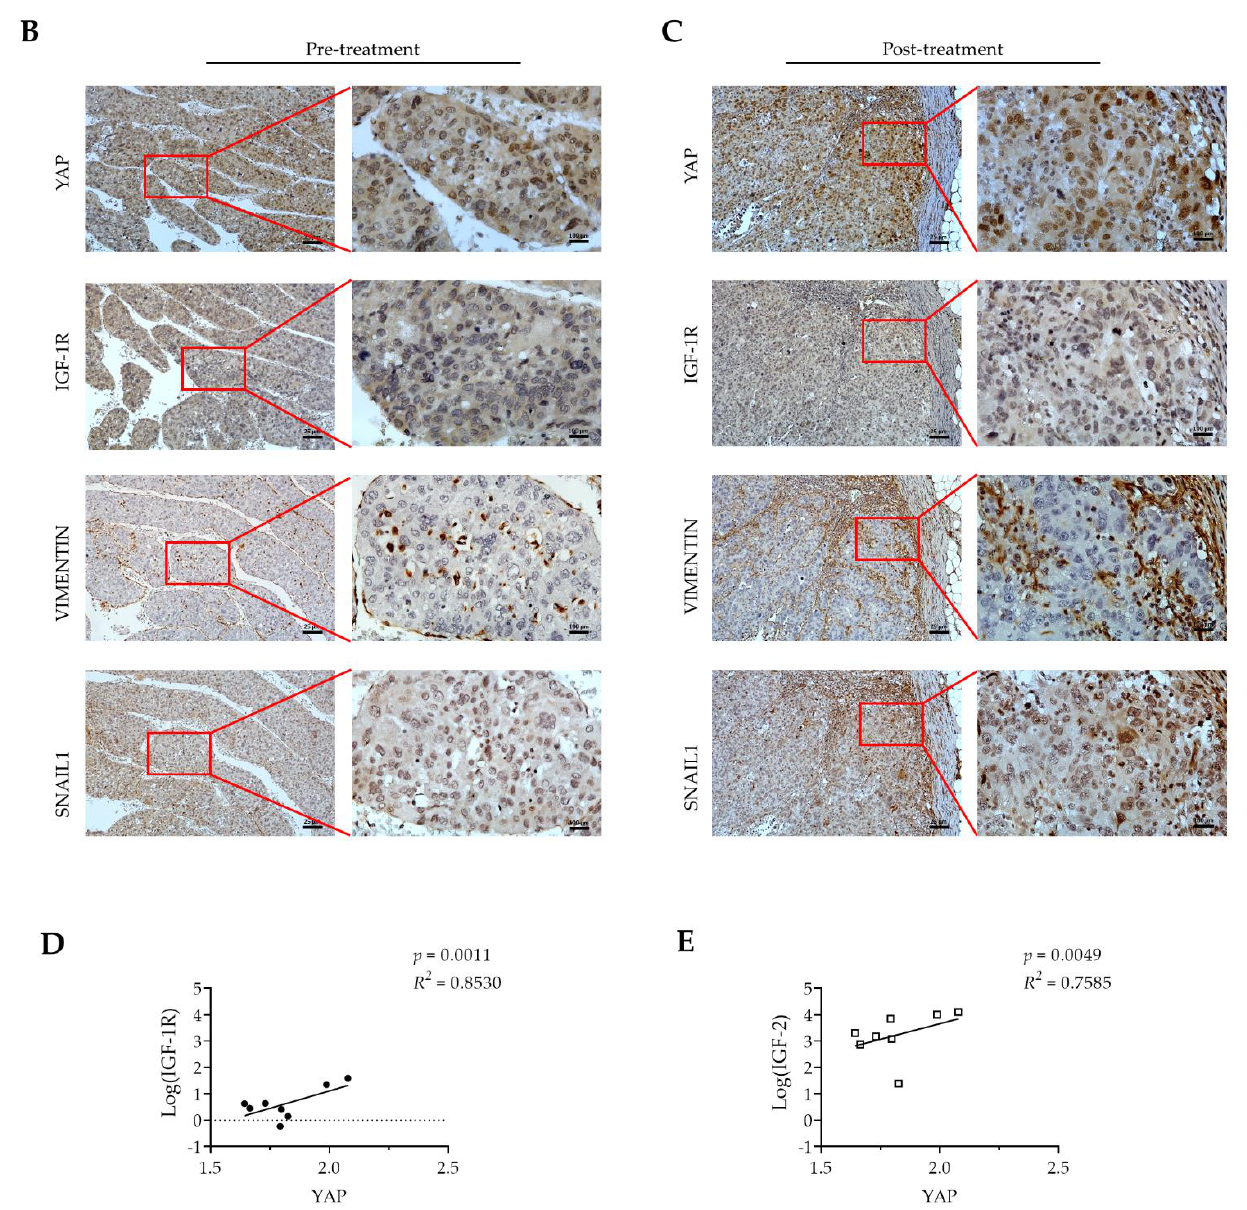
Figure 5. High expression of YAP is positively correlated with IGF-1R and EMT-related proteins in the tumor tissues of HCC patients who received sorafenib treatment. ( A ) Positive correlations of mRNA expression levels among YAP , IGF-1R , VIMENTIN , SNAIL1 , and E-CAD (also known as CDH1) in the HCC cohort of TCGA database using the GEPIA web server. Pearson’s χ 2 test. ( B ) The expression of YAP, IGF-1R, VIMENTIN, and SNAIL1 proteins in the HCC tissue from a patient pre-treatment and ( C ) 2 months post-sorafenib treatment through immunohistochemistry staining. The correlation of mRNA expression levels of YAP with ( D ) IGF-1R and ( E ) IGF-2 in the TCGA-sorafenib treatment cohort ( n = 8; Pearson’s χ 2 test). R 2 , Pearson’s correlation